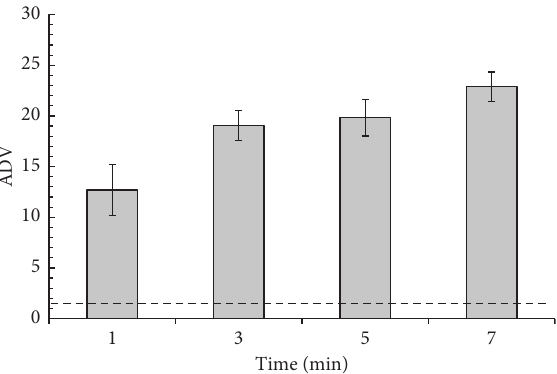
Figure 6: Hydrolytic rancidity (AVD) in Adobera cheese after CP treatment. The dotted line represents the limit value of ADV, a value > 1.5 ADV represents high rancidity.